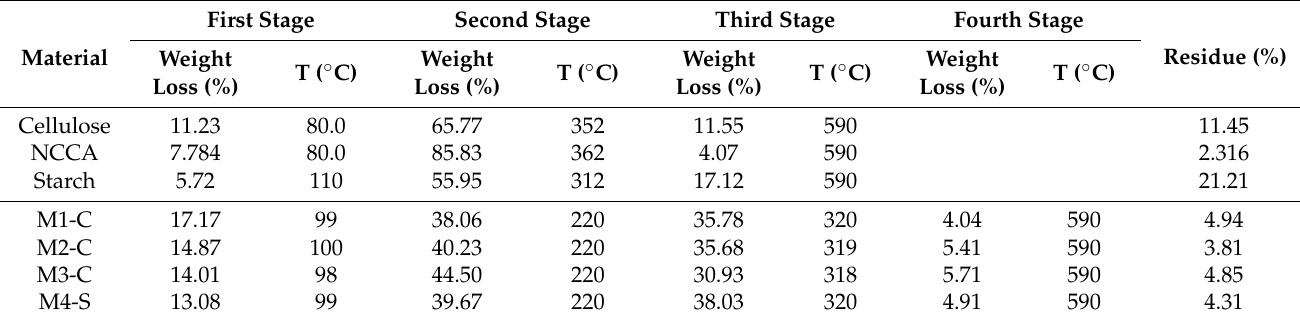
Figure 9. TGA thermogram for ( a ) raw materials, ( b ) films. Table 8. Weight loss and decomposition